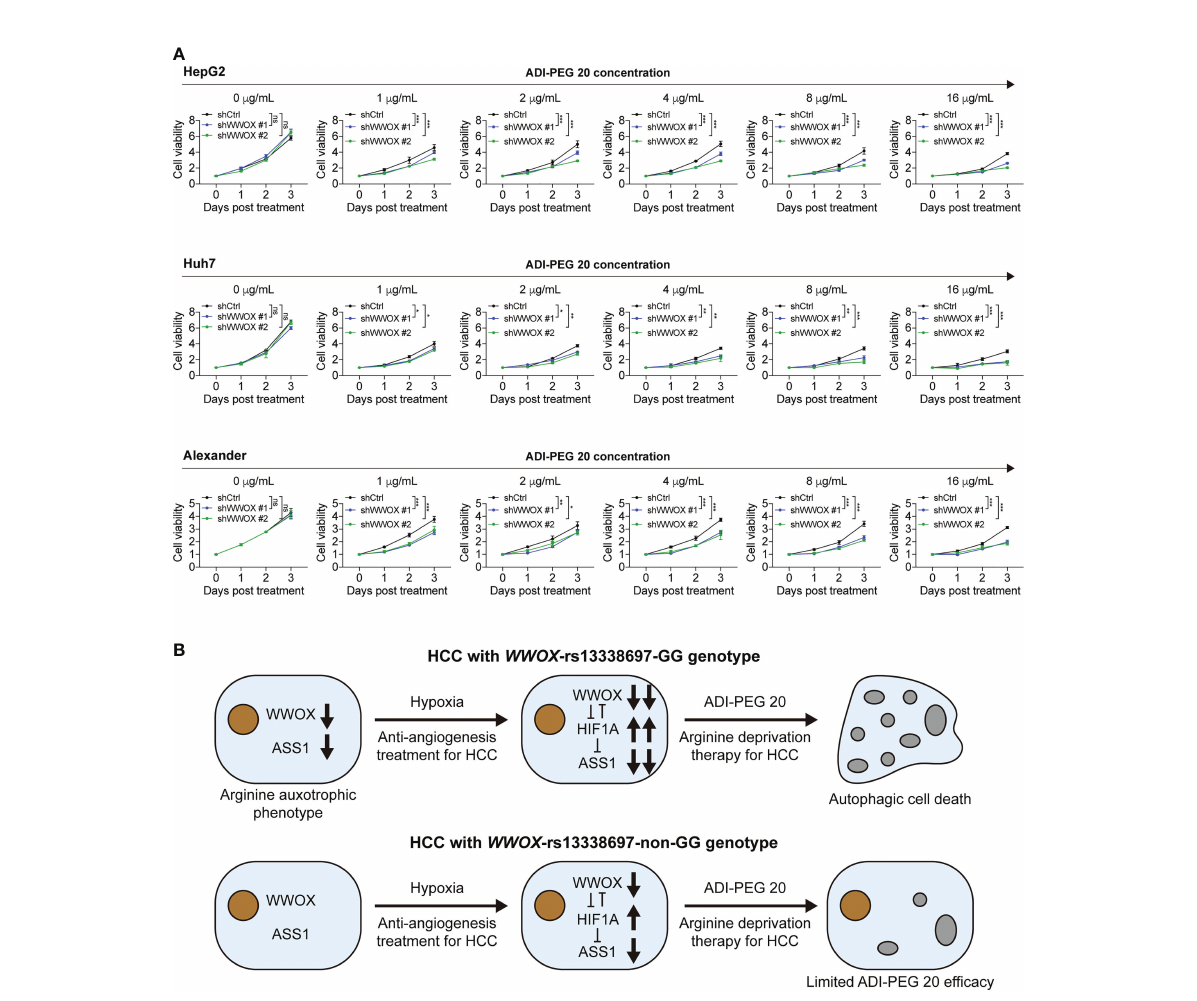
FIGURE 8 Silencing WWOX sensitizes HCC cells to ADI-PEG 20 under hypoxic conditions. (A) HCC cell viability when treated with the indicated concentrations of ADI-PEG 20, all under 100 m M CoCl 2 treatment. P values were obtained by two-way ANOVA and < 0.05 was considered signi fi cant. *P < 0.05; **P < 0.01; ***P < 0.001. (B) The proposed working model of this study. HCC patients with the WWOX -rs13338697-GG genotype were associated with lower WWOX and ASS1 levels and higher plasma arginine levels. Decreased ASS1 and elevated extracellular arginine demand resemble the arginine auxotrophic phenotype. Low WWOX protein expression in HCC in patients with the WWOX -rs13338697- GG genotype enhances the cellular hypoxic response through an increase in HIF1A. Since HIF1A is a known repressor of ASS1, increasing